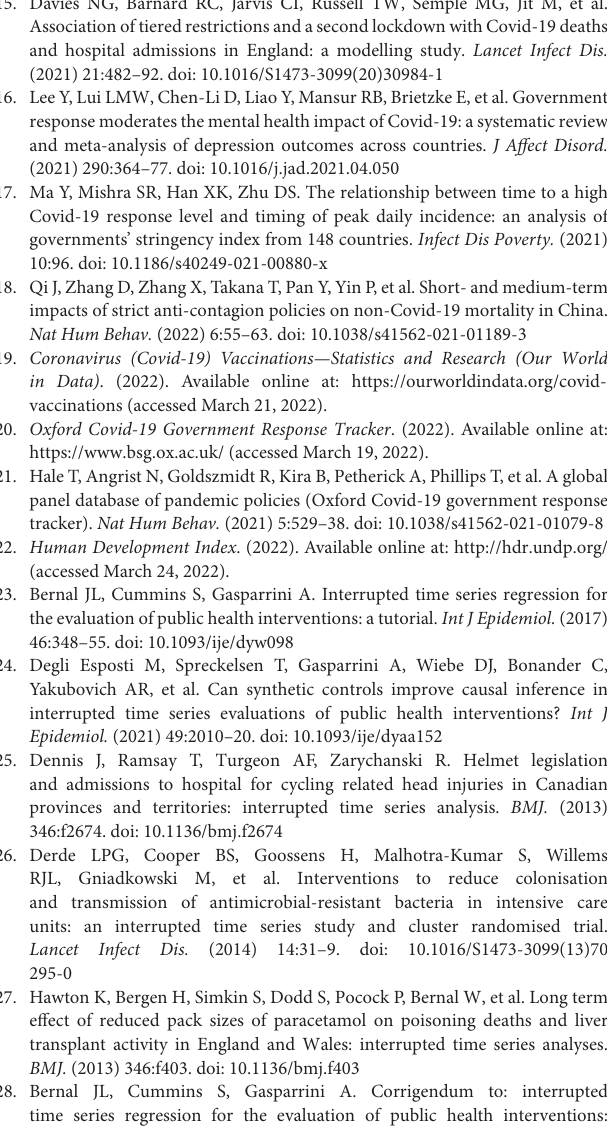
Supplementary Figure 1 | Short-term and long-term effects of vaccination on cases between two types of variants among continents. Parts (a) and (b) show the effects on cases of Alpha, Beta, Delta, etc variants. Parts (c) and (d) show the effects on cases of the Omicron variant. Red circles are filled if the value is significantly different from the null distribution ( p < 0.05), and open otherwise. The